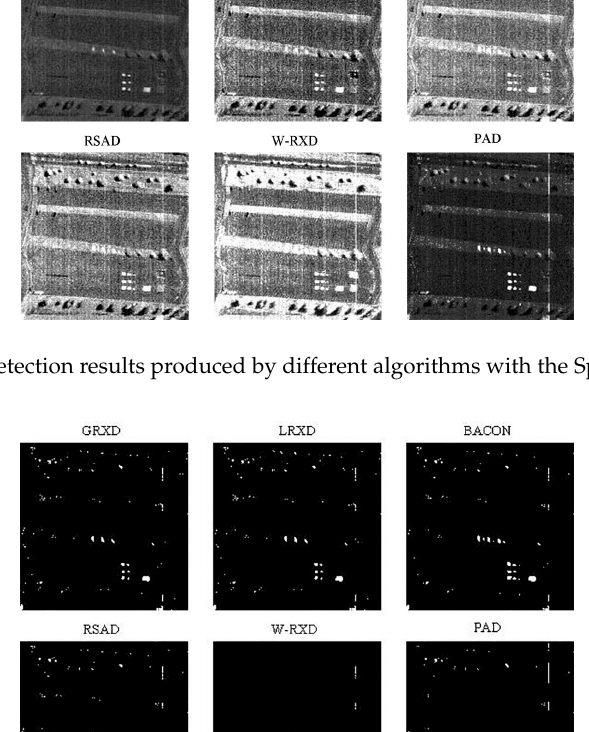
Figure 7. ROC curves corresponding to the detection results from the SpecTIR data presented in Figures 5 and 6.